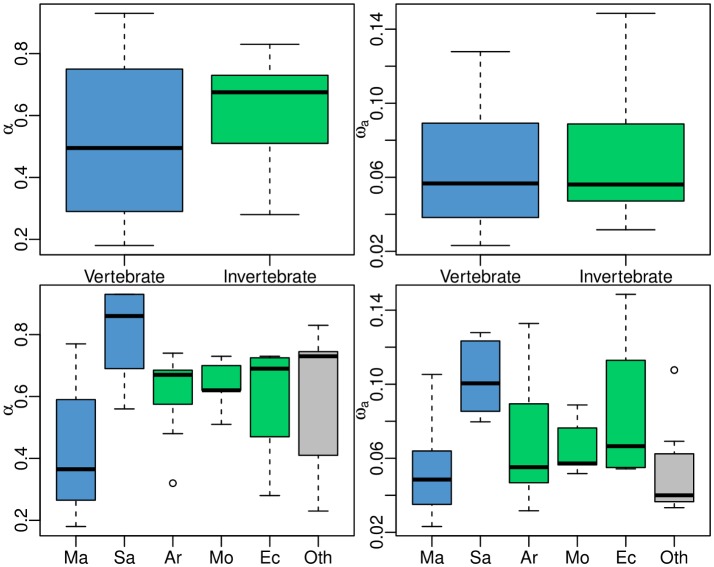
Distributions of α and ωa split by taxa.Ma: mammals; Sa: sauropsids; Ar: arthropods; Mo: molluscs; Ec: echinoderms; Ot: others